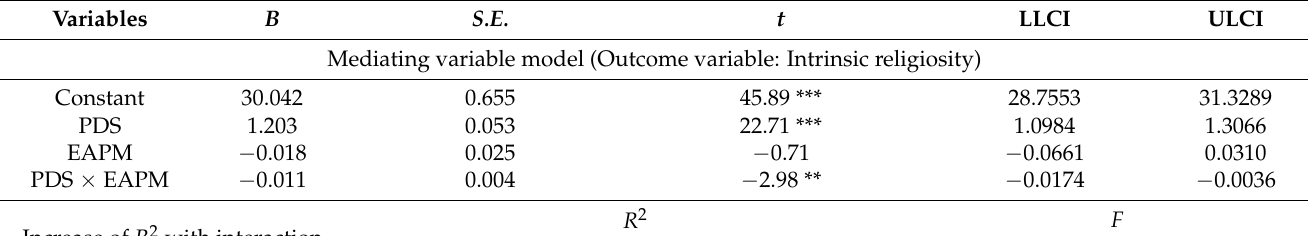
Table 3. Mediating effect of intrinsic religiosity moderated by the emotionally adaptive functions of music on the preoccupation with devotional songs and spiritual